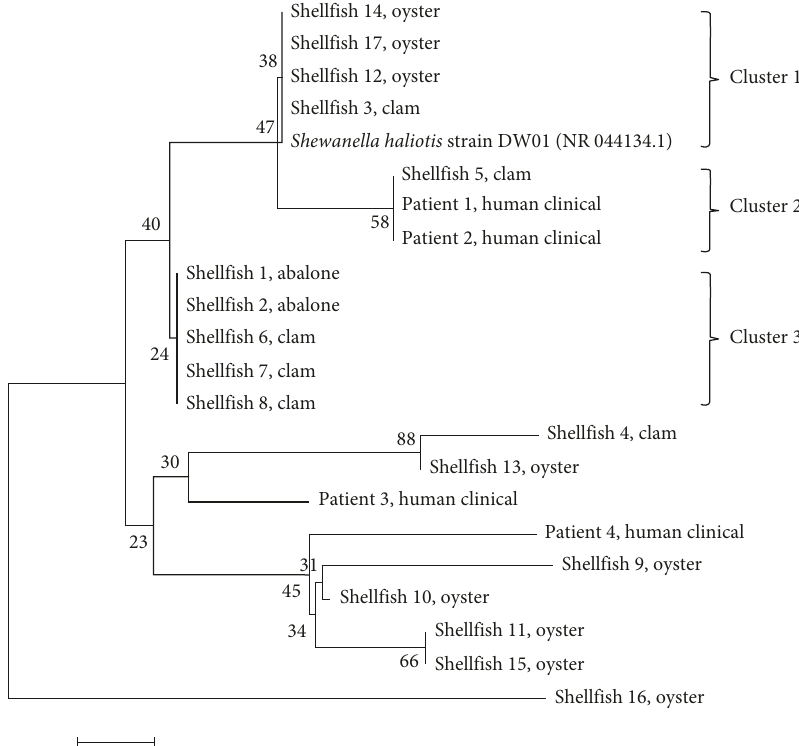
Figure 2: Phylogenetic tree based on 16S rDNA sequence showing the relationship between shellfish and clinical isolates of S. haliotis . The tree was drawn to scale with branch lengths in the same units as those of the evolutionary distances used to infer the phylogenetic tree. All positions containing gaps and missing data were eliminated. There were a total of 1320 positions in the final dataset. The scale bar indicates 0.0005 nucleotide substitutions per